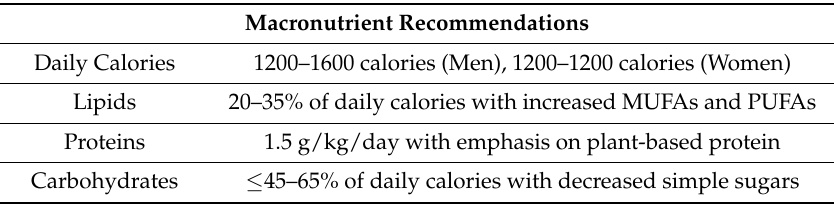
Table 1. Recommendations for Macronutrients.